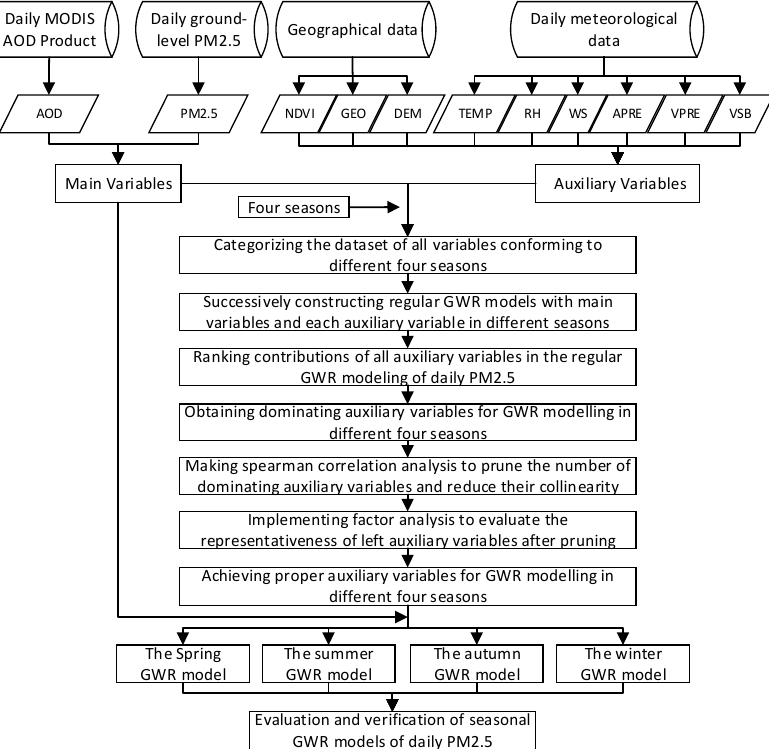
Figure 2. The procedure of constructing seasonal Geographically Weighted Regression (GWR) models with proper auxiliary variables.